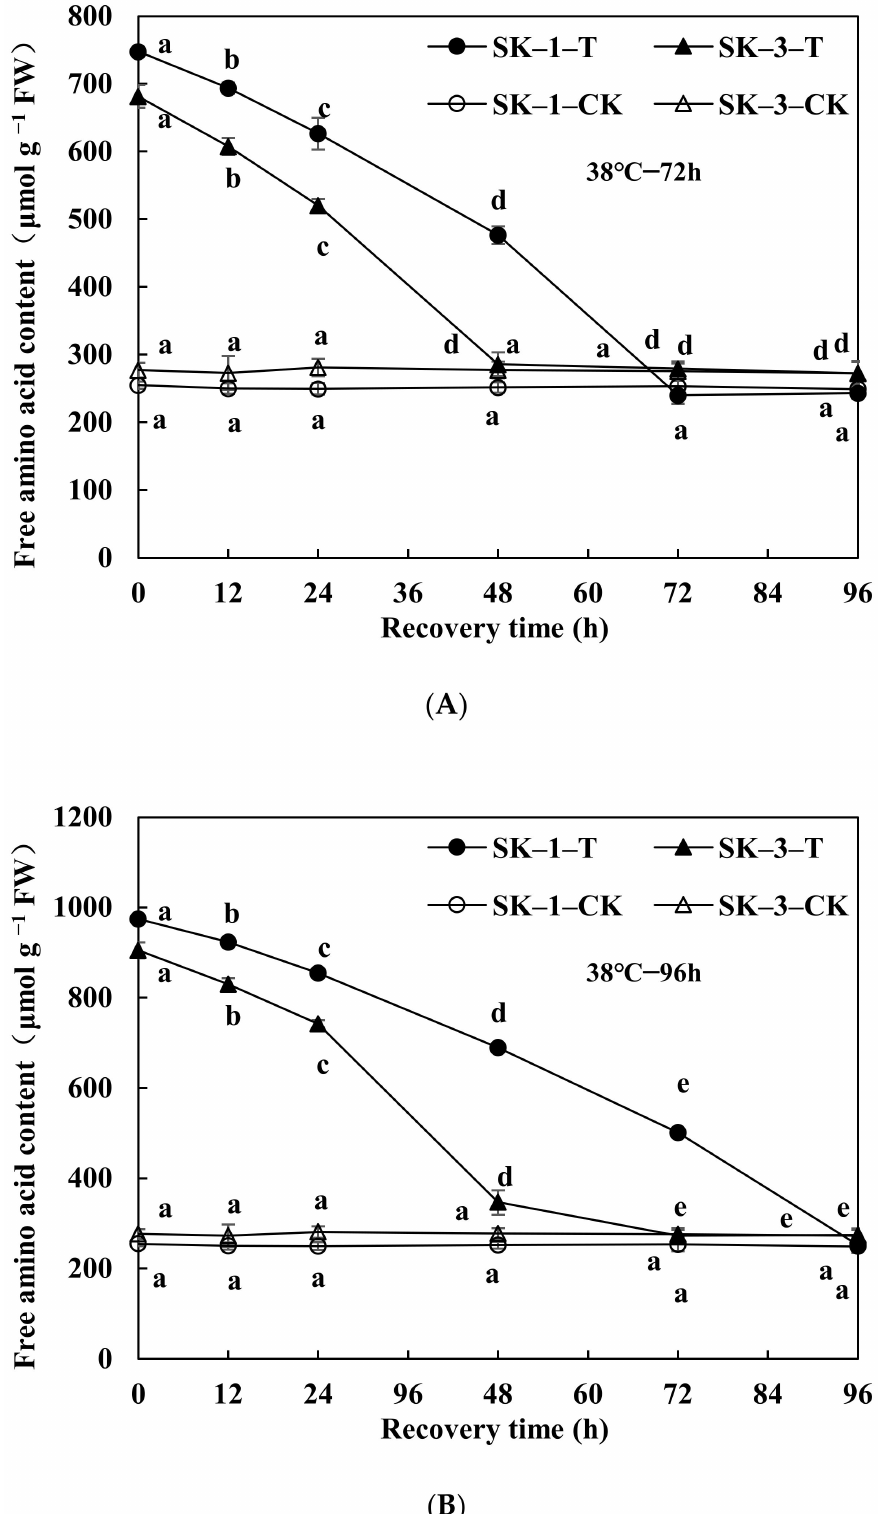
Figure 3. Changes in free amino acid content in squares of Bt cotton after 72 h ( A ) and 96 h ( B ) high-temperature stress termination. Free amino acid content at the recovery time with different lowercase letters is significantly different from the control at p < 0.05 under the same high-temperature stress duration for the same cultivar. T—treatments for 72 h ( A ) and 96 h ( B );